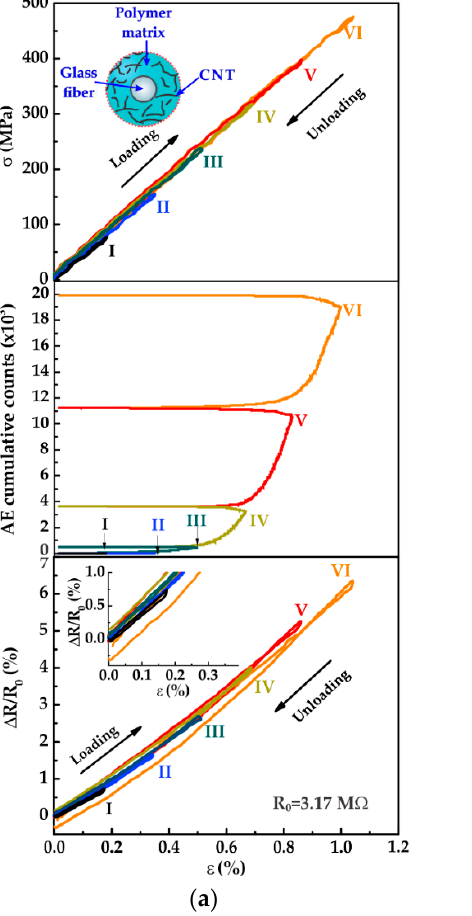
Figure 6. Coupled mechanical ( Top ), AE ( Middle ), and electromechanical ( Bottom ) responses of hierarchical composites under incrementally-increasing cyclic tensile loading. ( a ) Composite architecture m , ( b ) composite architecture f .